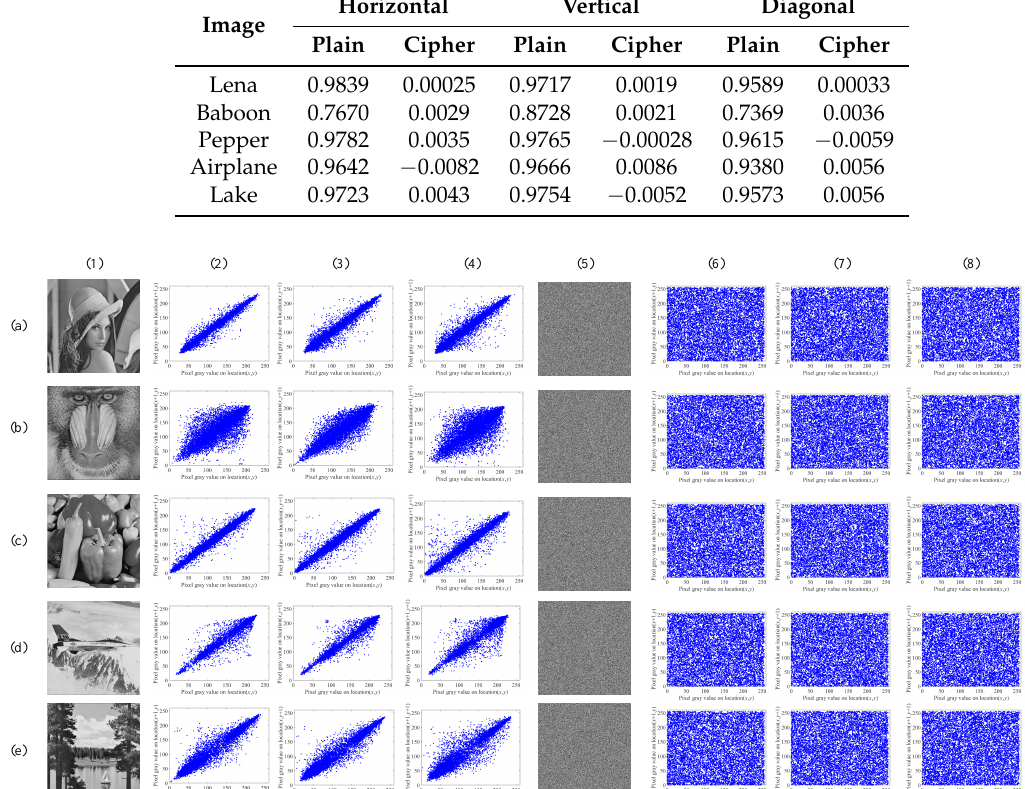
Figure 6. Correlation distributions. Rows ( a )–( e ) correspond to images of ‘Lena’, ‘Baboon’, ‘Pepper’, ‘Airplane’ and ‘Lake’, respectively; Column (1) shows the corresponding plain images; Columns (2)–(4) correspond to the plain images’ distributions of ‘horizontal direction’, ‘vertical direction’ and ‘diagonal direction’, respectively; Column (5) is the corresponding cipher images by encryption; Columns (6)–(8) correspond to the cipher images’ distributions of ‘horizontal direction’, ‘vertical direction’ and ‘diagonal direction’,